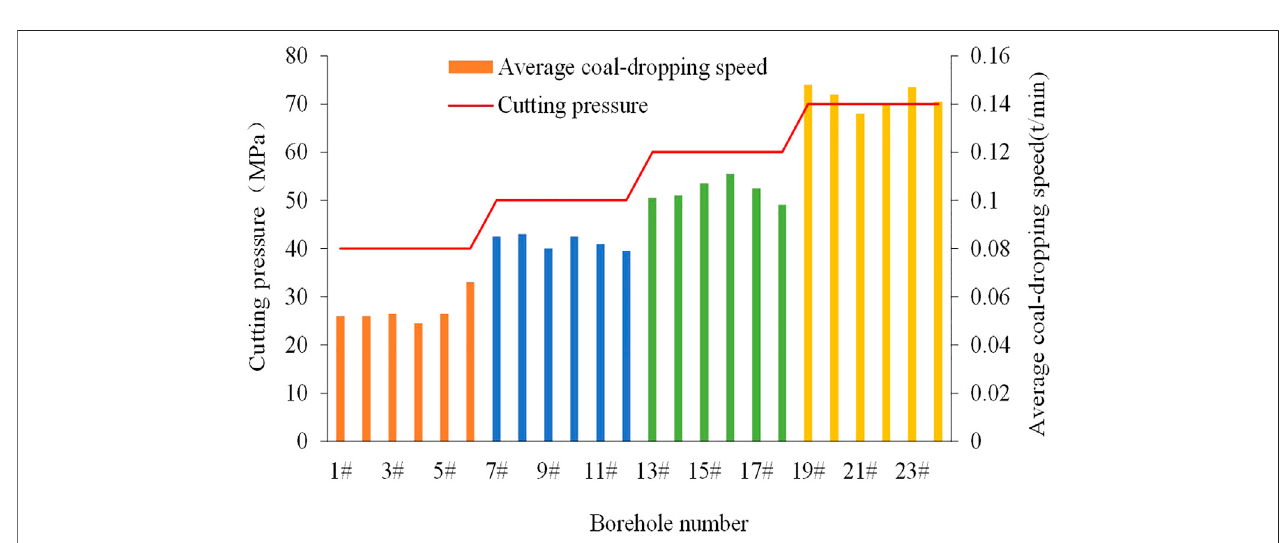
FIGURE 2 | Relationship curve between the cutting pressure and the coal-dropping speed in coal seams with Protodyakonov coef fi cient in the range of 0.2 – 0.3.